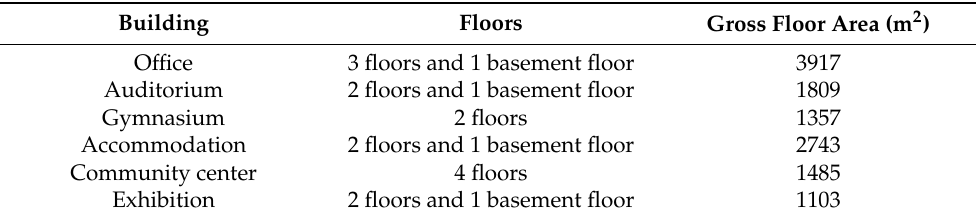
Table 2. Building